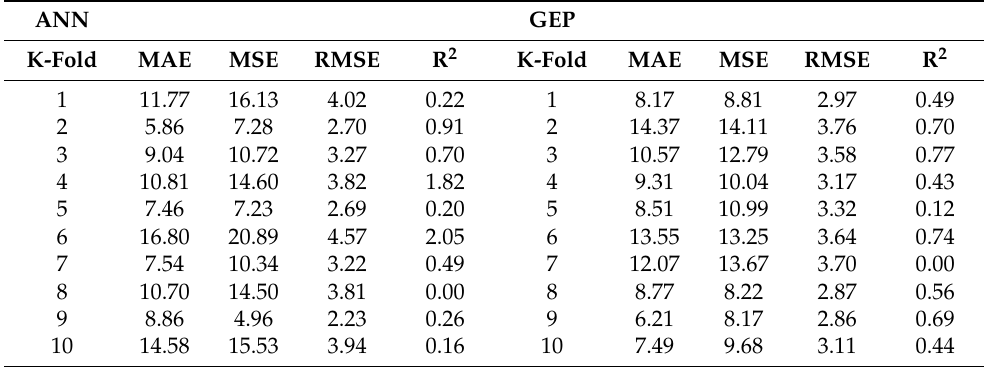
Table 3. Analysis of the k-fold cross-validation of ANN and GEP models.